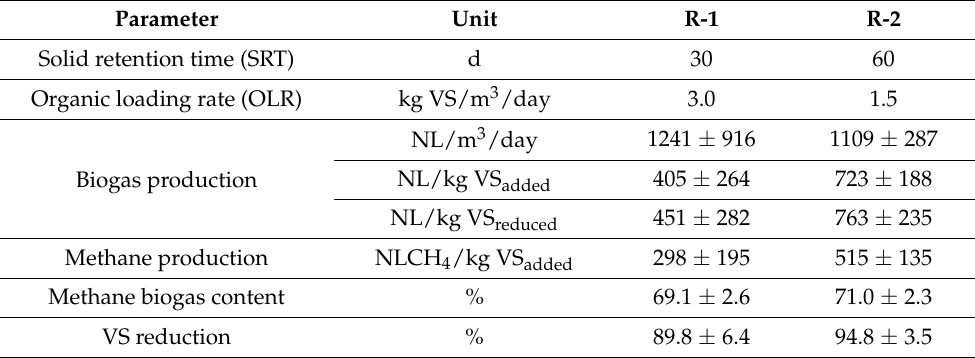
Table 3. Operating parameters and performances of semicontinuous